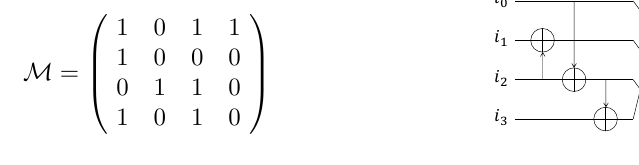
Figure 1: Matrix for MixColumns